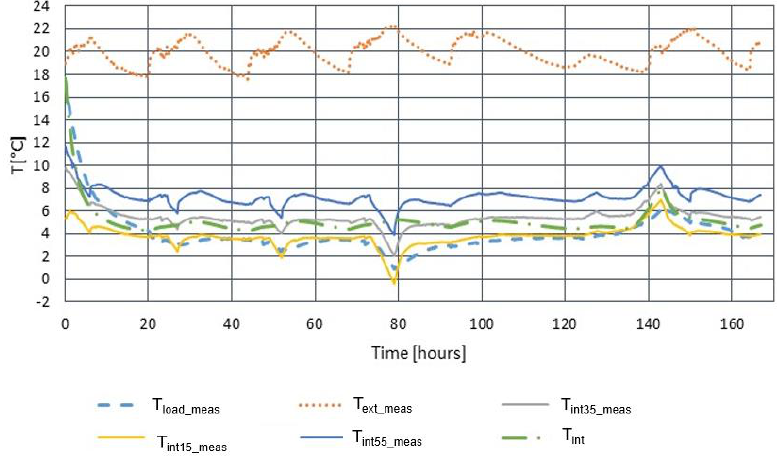
Figure 6. Comparison of the simulated average internal air temperature and the various temperatures measured during a typical working week.